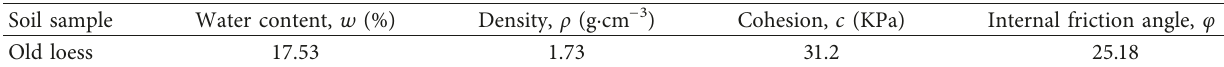
Figure 1: Test system. Table 1: Physical and mechanical indexes of